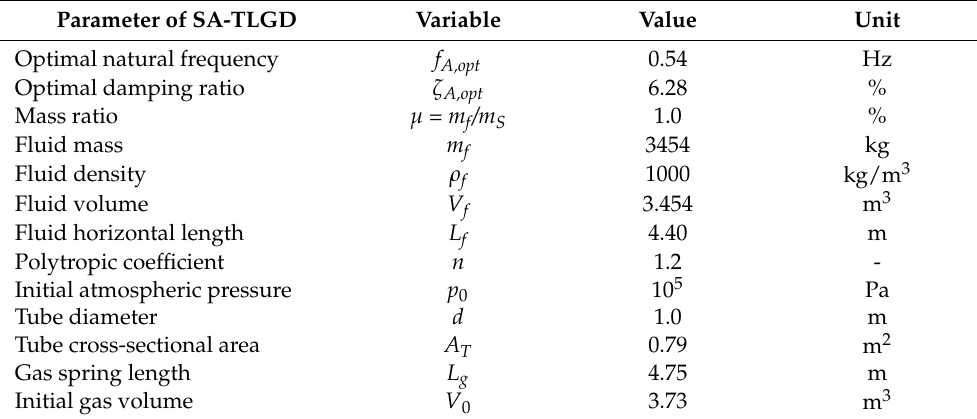
Table 2. Parameters and dimensions of the optimized SA-TLGD attached to the SDOF-wind turbine. Parameter of SA-TLGD Variable Value Unit Optimal natural frequency f A,opt